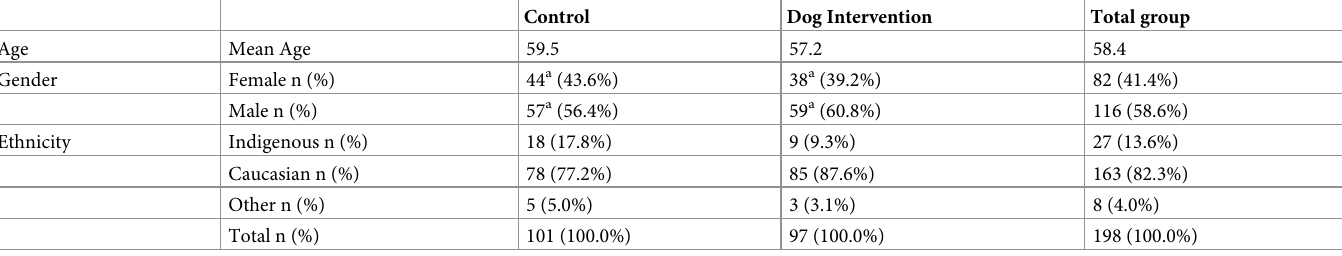
Table 2. Demographics by